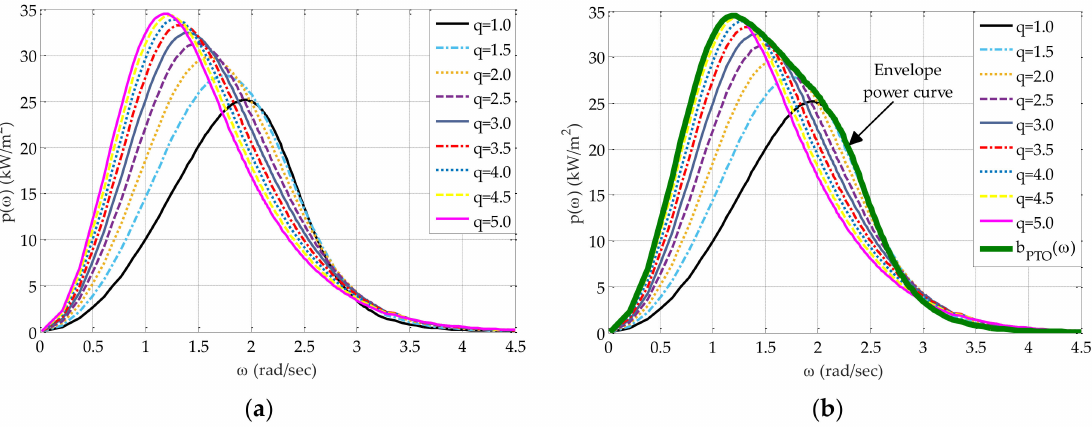
Figure 16. Isolated oblate spheroidal WEC: ( a ) power absorption curves for b PTO = qB ISO 1.0, 1.5, 2.0, 2.5, 3.0, 3.5, 4.0, 4.5, and 5.0; ( b ) envelope power curve representing the utilization of an “active” PTO mechanism with b PTO ( ω ) .